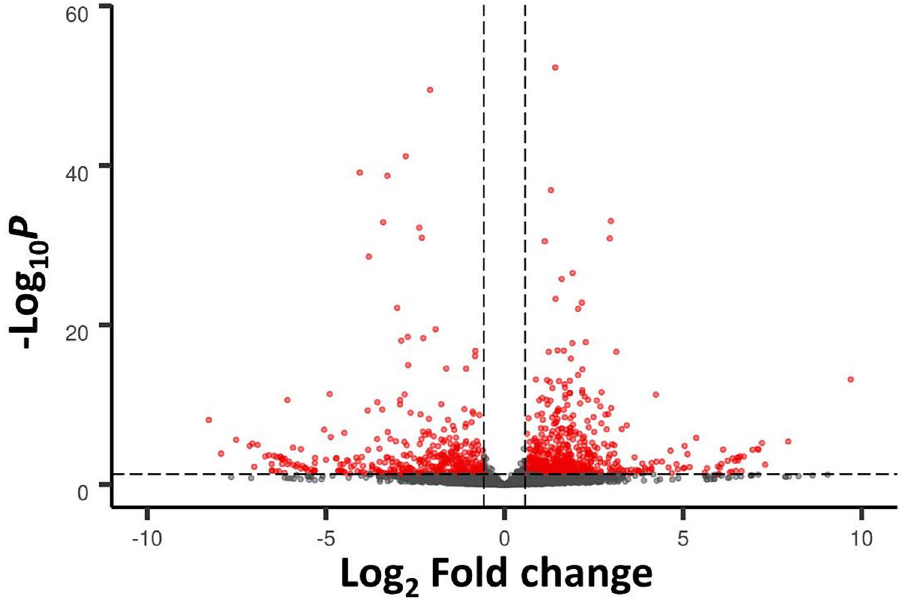
Figure 1. Differentially expressed long non-coding RNAs (lncRNAs) detected by RNA-Seq in adult S. mansoni females treated with 5-AzaC. These results were obtained by re-analysis of the RNA-Seq data from Geyer et al. 16 using the S. mansoni lncRNA transcriptome published in Maciel et al. 31 as reference. In Geyer et al. 16 , parasites were cultured either in the presence or absence of 491 μM 5-AzaC for 48 h. LncRNA gene expression levels identified in this RNA-Seq dataset are shown with a volcano plot, which displays the differentially expressed lncRNAs between 5-AzaC-treated and control S. mansoni females (red dots, showing FDR < 0.05 and log2FC > 0.59 or < -0.59, dotted lines). Grey dots represent non-differentially expressed lncRNAs. 912 lncRNAs were considered significantly differentially expressed, being 522 long intergenic ncRNAs, 358 antisense lncRNAs and 32 sense